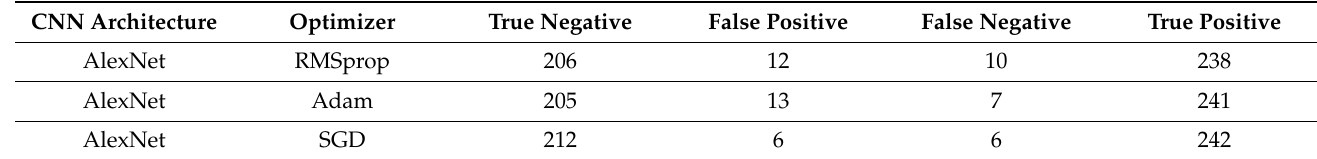
Table 4. AlexNet confusion matrix (validation).